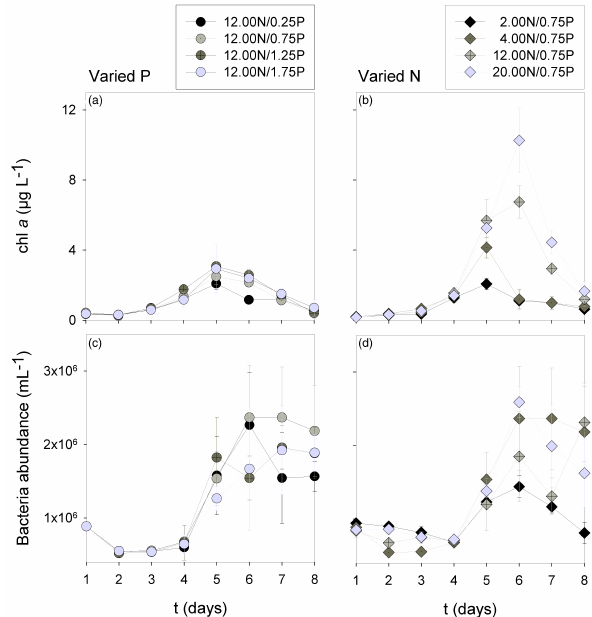
Figure 1. Mean development of chl a (a) , bacterial abundance (c) in replicated treatments during Varied P; and chl a (b) , bacterial abun- dance (d) in replicated treatments during Varied